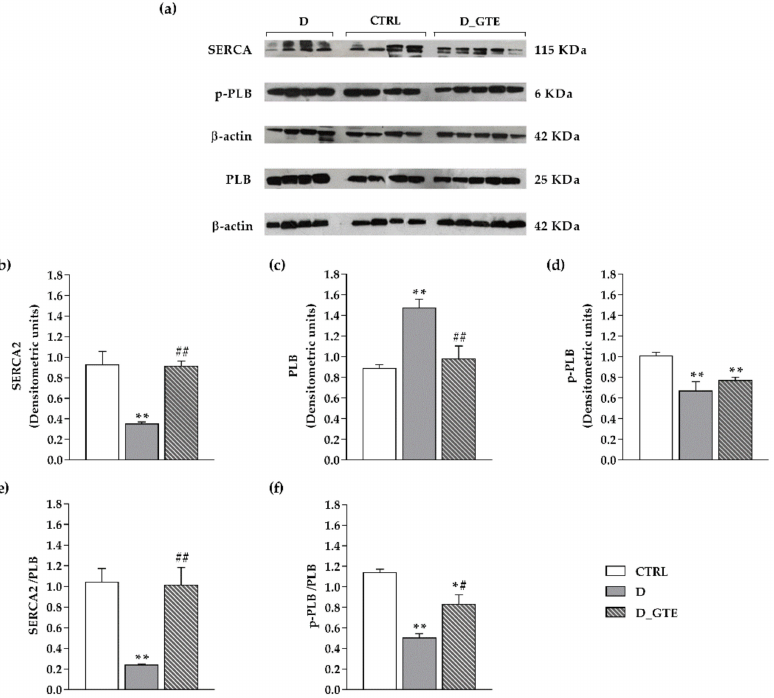
Figure 5. SERCA2, PLB, and p-PLB protein expression levels. ( a ) Typical electrophoretic separation and immunodetection of SERCA2, PLB and p-PLB in the heart tissue of CTRL, D and D_GTE rats. The expression levels (densitometric units) of ( b ) SERCA2, ( c ) PLB and ( d ) p-PLB were measured by densitometric analysis and normalized to b-actin. ( e ) SERCA2/PLB and ( f ) p-PLB/PLB. Histograms show the mean ± SEM. ** p < 0.01 significant differences vs. CTRL; * p < 0.05 significant differences vs. CTRL; ## p < 0.01 significant differences vs. D; # p < 0.05 significant differences vs. D (two-way